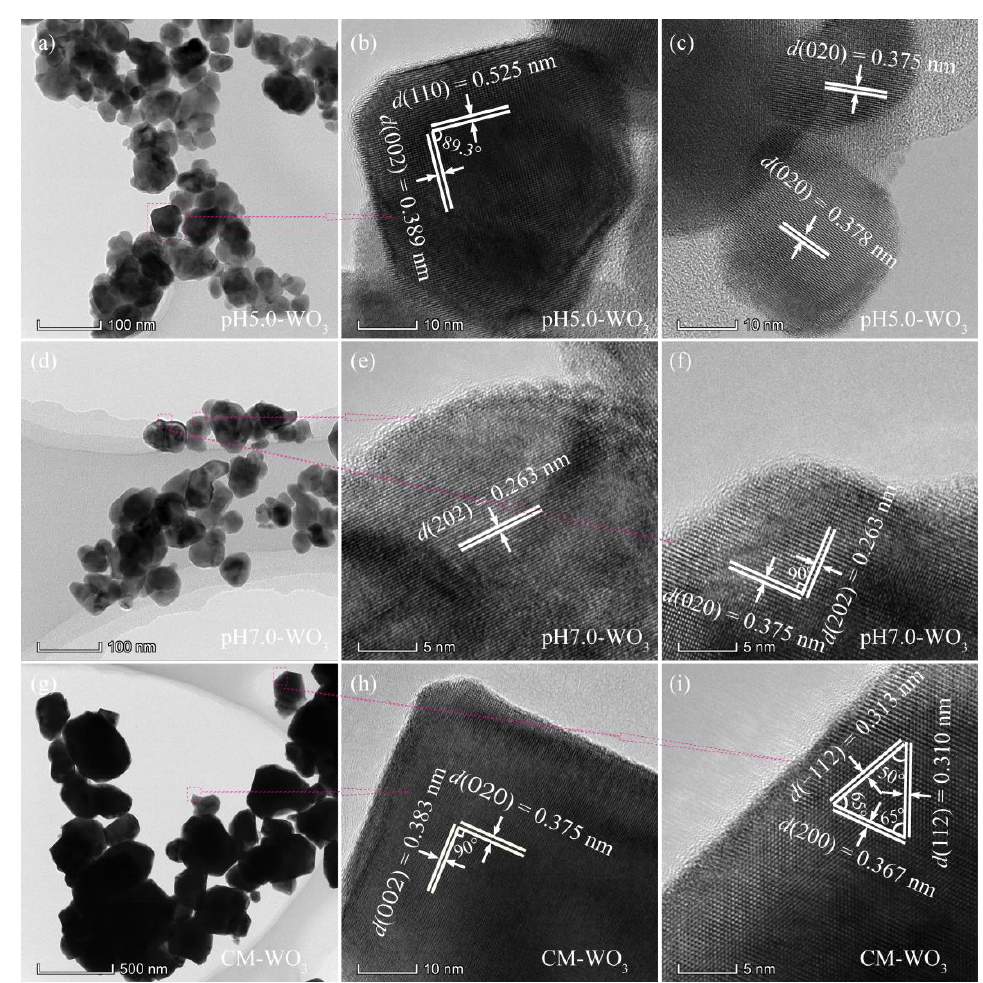
Figure 5. TEM and HRTEM images for: ( a – c ) pH5.0-WO 3 , ( d – f ) pH7.0-WO 3 , and ( g – i ) CM-WO 3 .